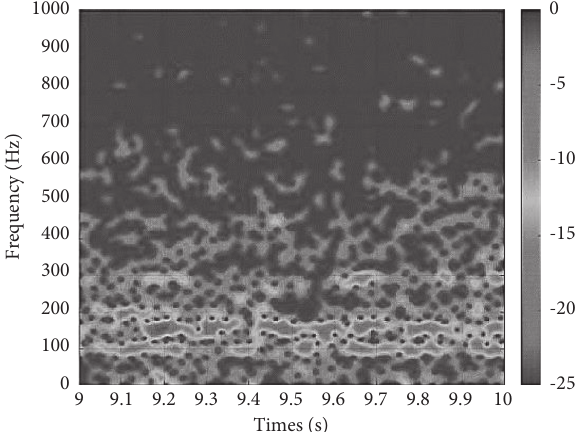
Figure 10: Time-frequency of the background